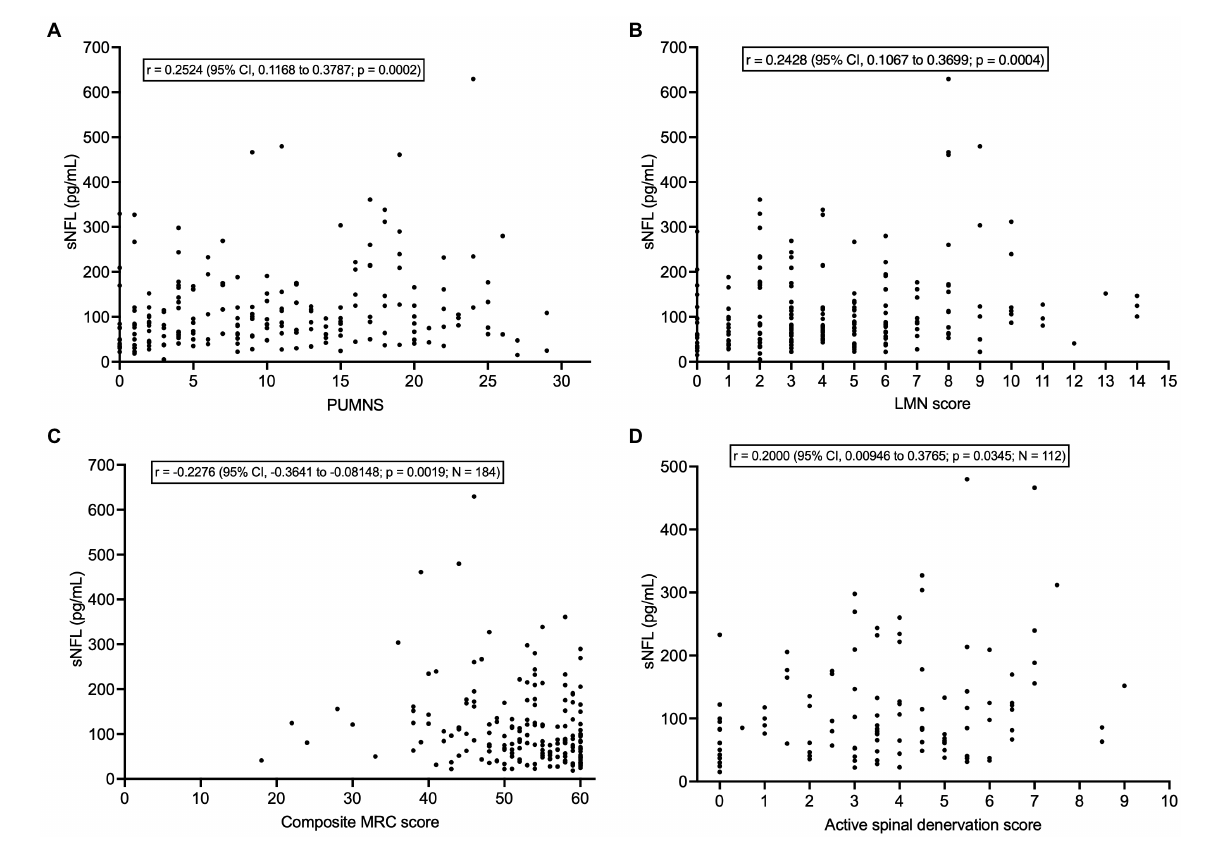
FIGURE 5 Correlations of serum NFL levels with clinical/neurophysiological indices of UMN and LMN dysfunction. (A) Correlation between sNFL and PUMNS. (B) Correlation between sNFL and LMN score. (C) Correlation between sNFL and composite MRC score. (D) Correlation between sNFL and active spinal denervation score. CI, confidence interval; LMN, lower motor neuron; MRC, Medical Research Council; NFL, neurofilament light chain; PUMNS, Penn Upper Motor Neuron Score; sNFL, serum neurofilament light chain; UMN, upper motor